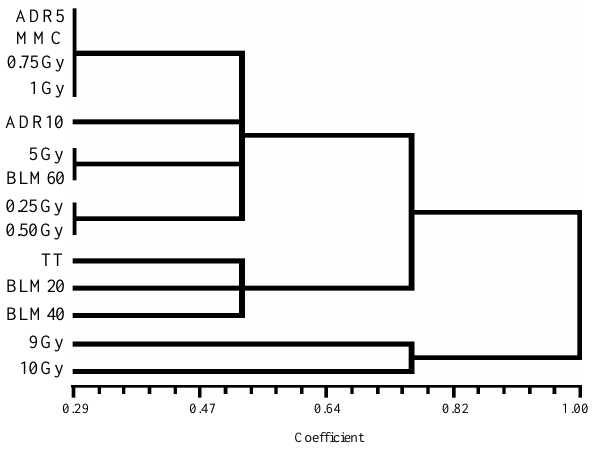
Figure 1 - A-D - Phenogram (UPGMA) of association (Jaccard coefficient) obtained from the 14 treatments. CCC was 0.93885. See references on Mate- rial and Methods, and Table I.